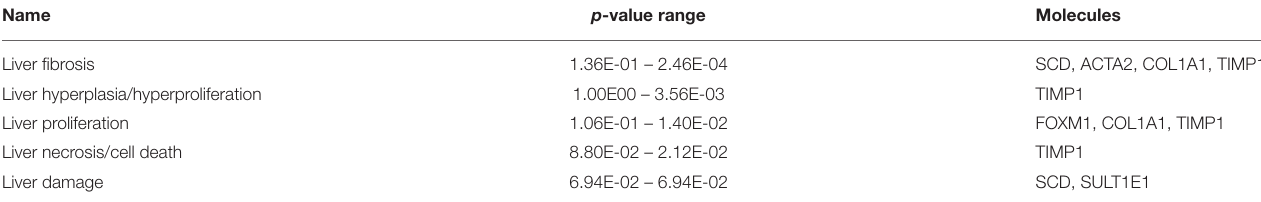
TABLE 9 | Hepatotoxicity between Phb1 + / − and